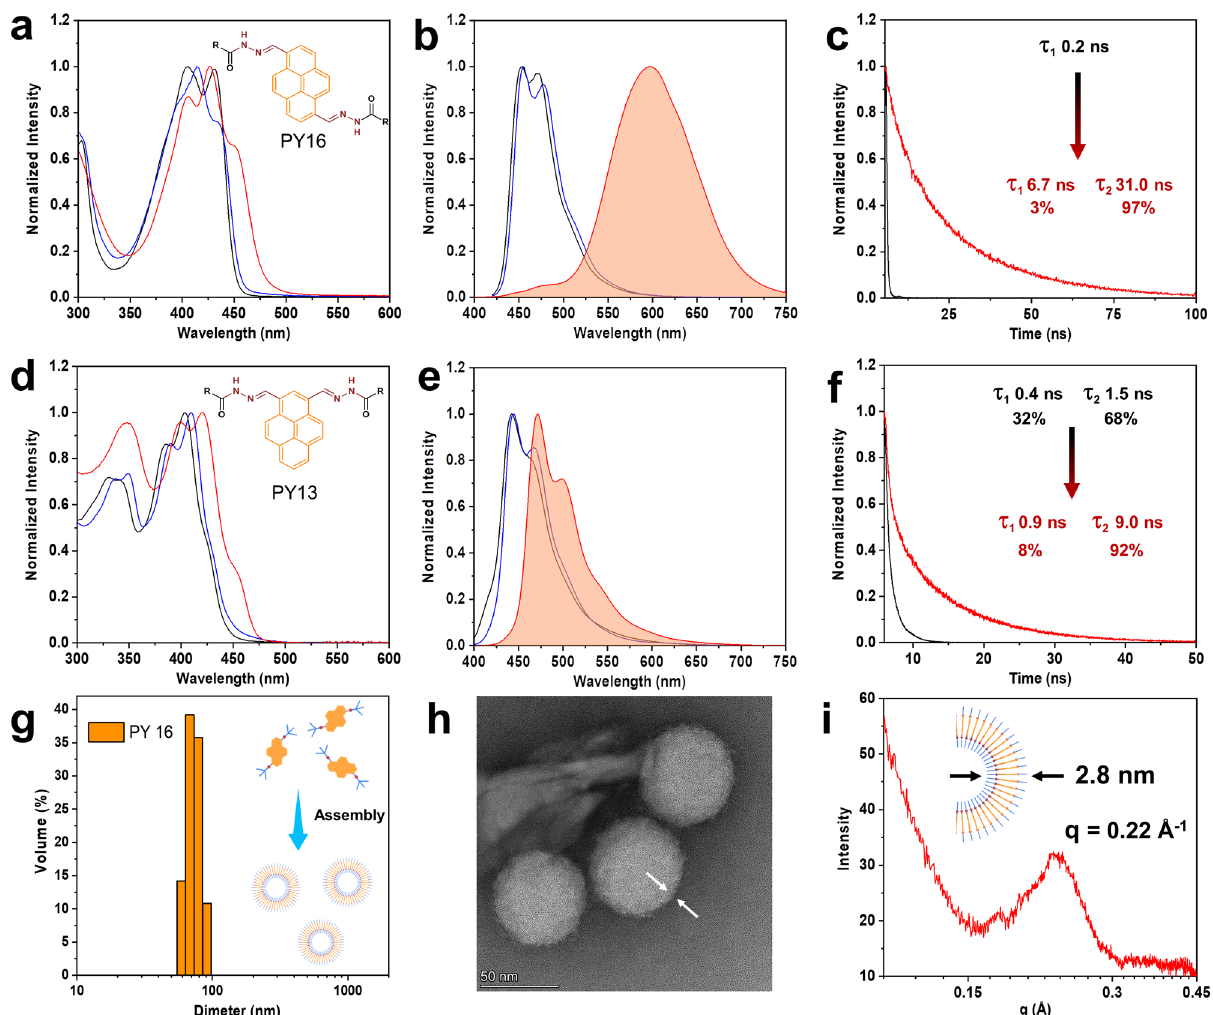
Fig. 2 Amphiphilic self-assembly and photophysical studies of two compounds (25 °C, 20 μ M). a , d UV – Vis absorption spectra and b , e fl uorescence spectra of the compounds in various solvents (black line: dichloromethane, blue line: dimethyl sulfoxide, red line: water), λ ex = 380 nm. c , f Corresponding time-resolved fl uorescence decay ( fi tting) curves of the compound (black line: dimethyl sulfoxide, red line: water), λ ex = 380 nm. g DLS data of PY16 in an aqueous solution (25 °C, 0.1 mM). h TEM image of PY16 , which self-assembles to form vesicles in an aqueous solution (25 °C, 0.1 mM). i Synchrotron radiation SAXS pattern of the vesicles.